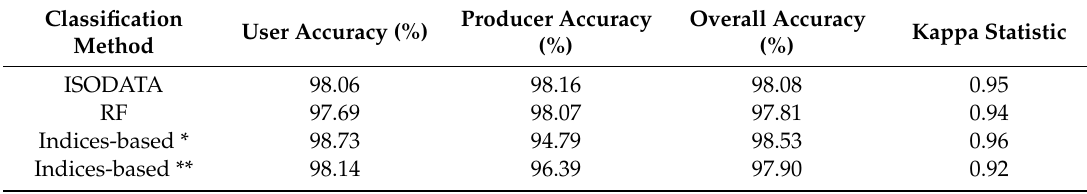
Table 6. Comparison of the accuracy assessments of the classified LULC